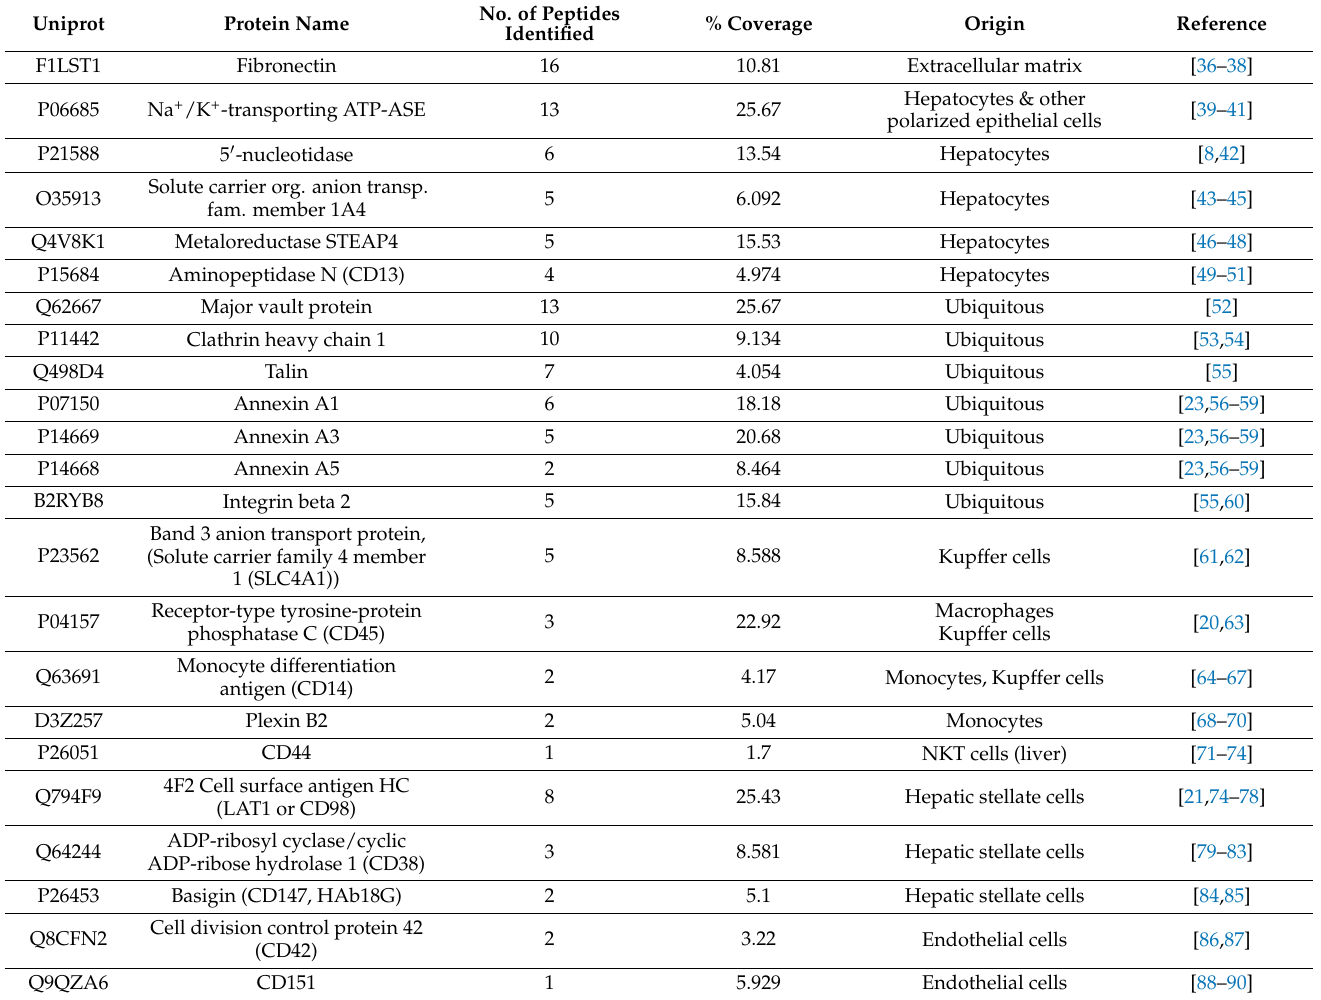
Table 2. List of proteins detected in EVs shed by APAP-treated liver according to their cellular